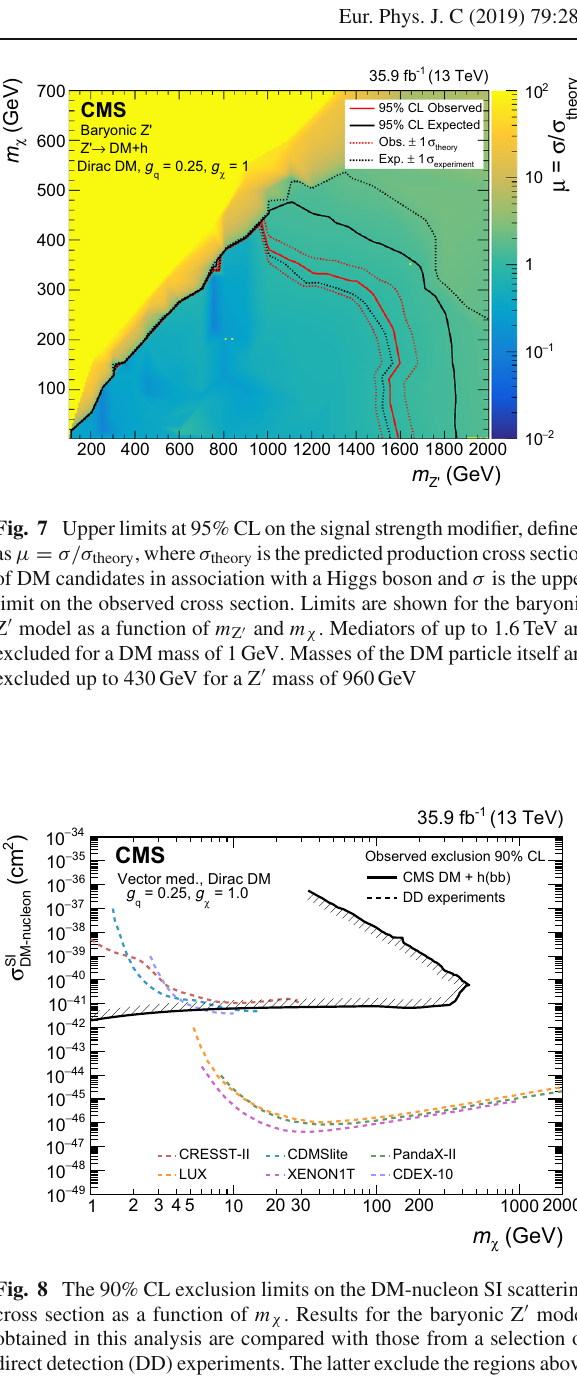
coupling to SM particles, and m med is the mass of the medi- ator. The resulting σ SI limits as a function of the DM mass are shown in Fig. 8. Under the assumptions made for the baryonic Z (cid:3) model, these limits on the DM-nucleon SI cross section are the most stringent to date for m χ < 5